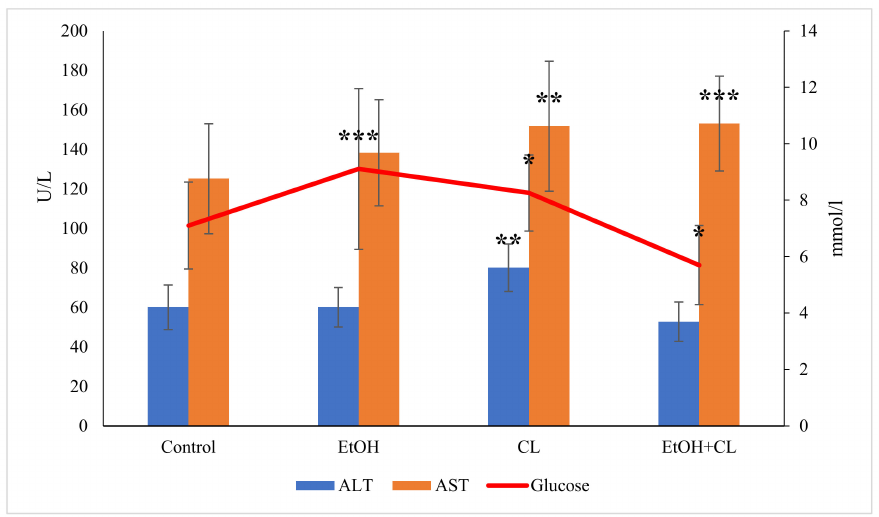
Figure 7. Glucose content and activity of ALT and AST in the blood plasma of rats, * p < 0.05, ** p < 0.01, *** p <